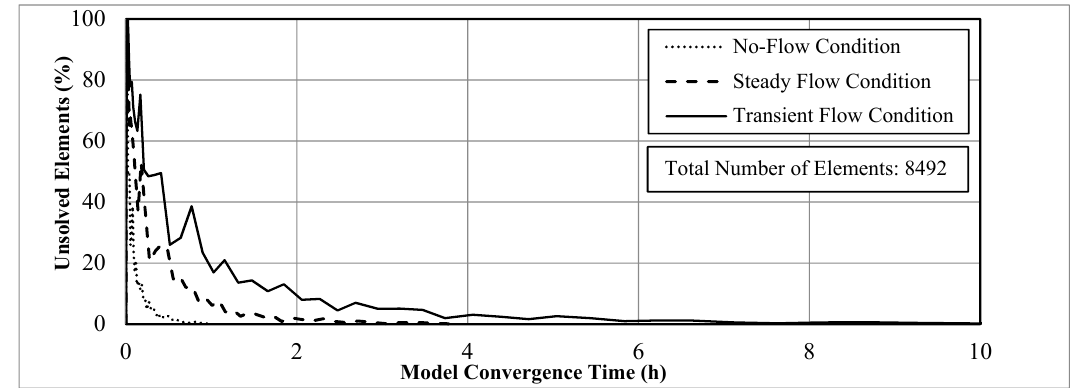
Figure 7. Convergence of the model for all scenarios.